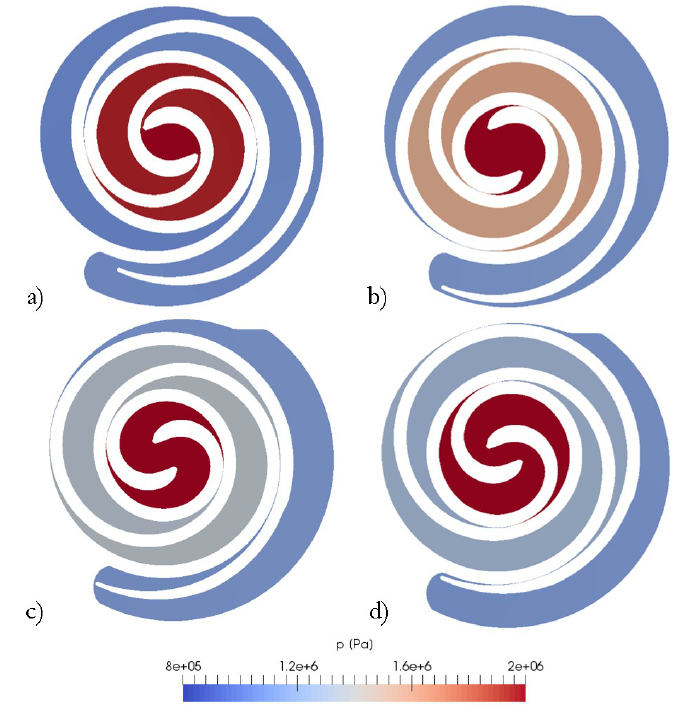
Figure 5. Pressure pattern evolution during the operation of the expander: ( a ) 0 ◦ , ( b ) 90 ◦ , ( c ) 180 ◦ , and ( d ) 270 ◦ .